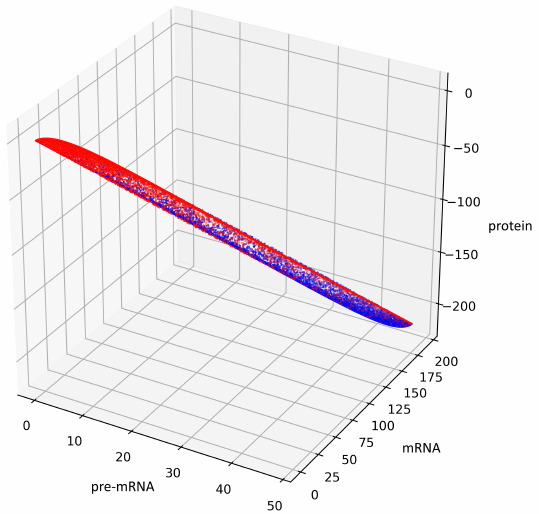
, b = 3 , c = 2 after 2 3 4